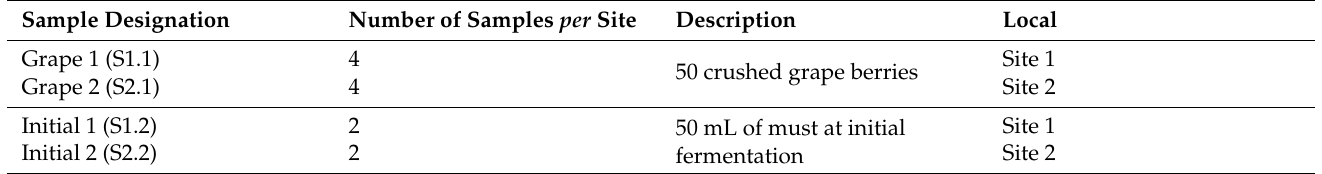
Table 1. Description, number of replicates and designation of the